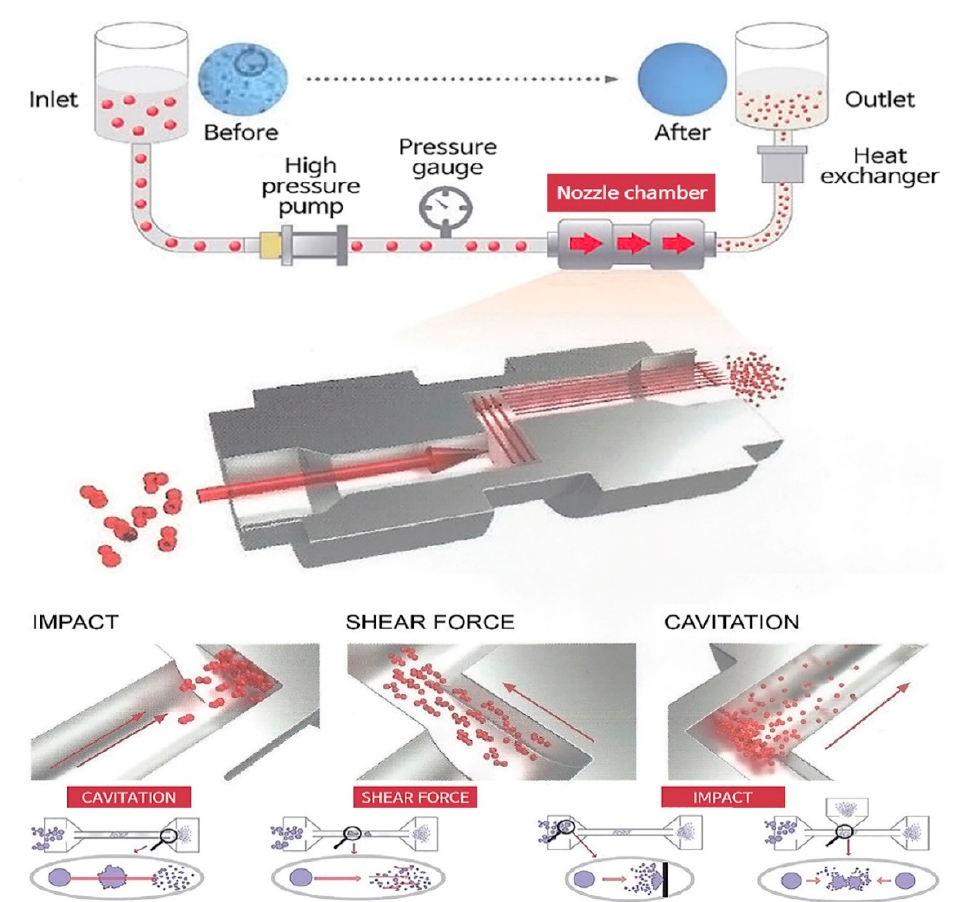
Figure 2. Underlying principle of high-pressure dispersion (adapted from Ilshin Autoclave Co., Ltd.).